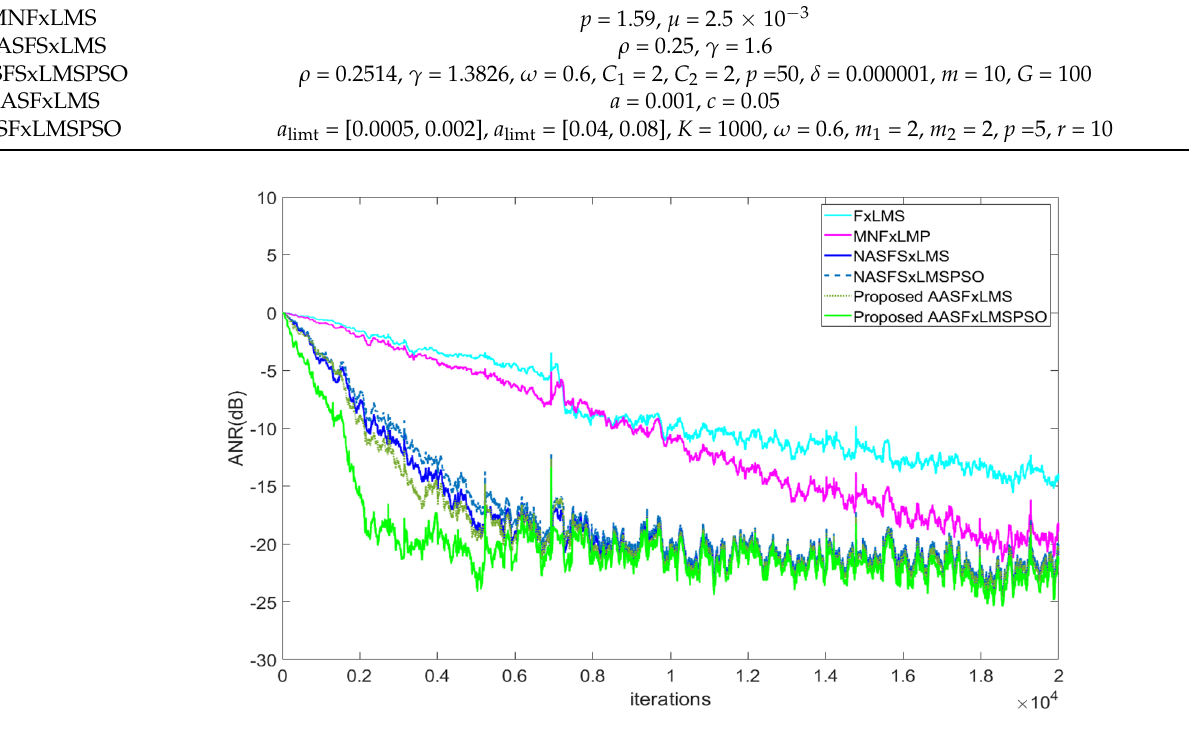
Figure 7. The noise reduction effect of the S α S distributed pulse noise, where α = 1.7.